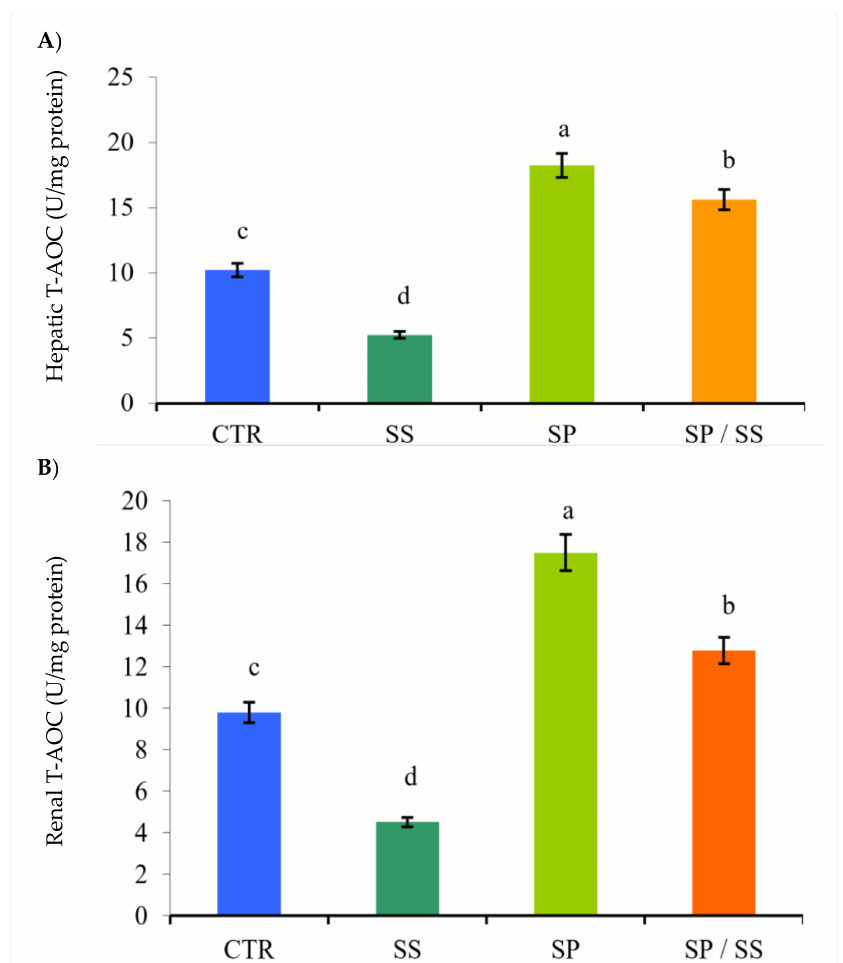
Figure 3. Total antioxidant capacity (T-AOC) levels in the liver ( A ) and kidney ( B ) tissues of Nile tilapia after sodium sulphate (SS) exposure and fed diets with or without S. platensis (SP) for 8 weeks. Values are expressed as mean ± standard errors (SE) ( n = 3). a,b,c,d = letters on top of the bars show that the groups are significantly di ff erent from those in the control group (CTR) ( p <